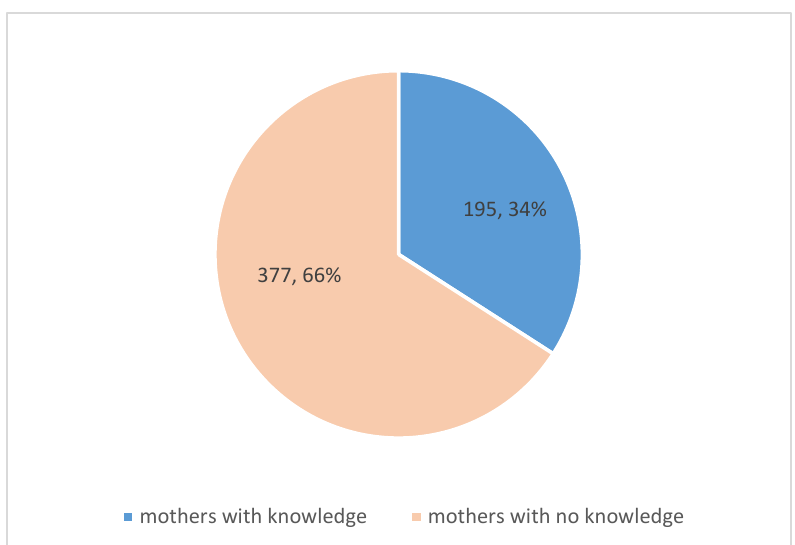
Figure 1: the level of Mother's Knowledge regarding the impact of breastfeeding on the occlusion